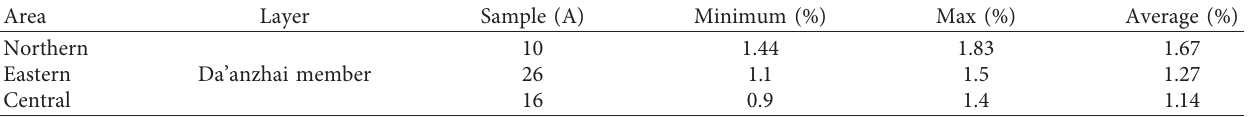
Table 3: Ro statistical table of Da’anzhai Member of Jurassic shale in Sichuan Basin.